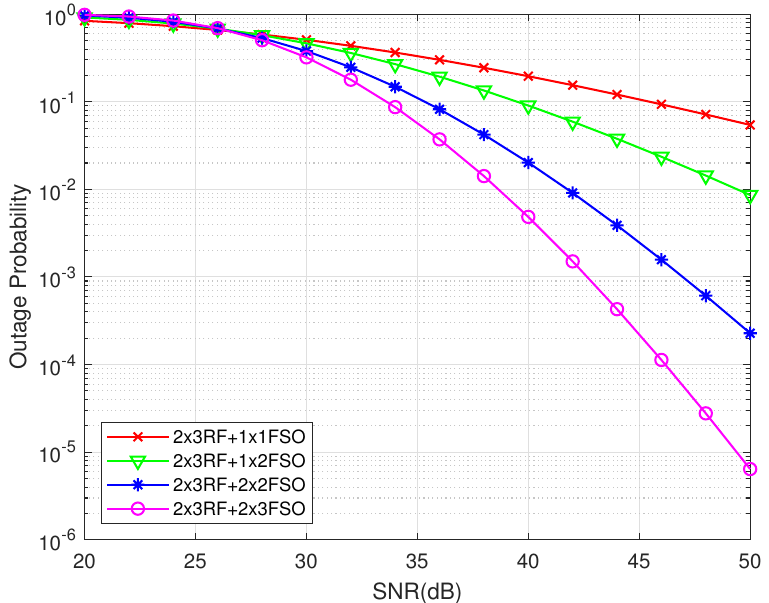
Figure 2. Outage probability of different scheme MIMO mixed RF/FSO systems with pointing error.